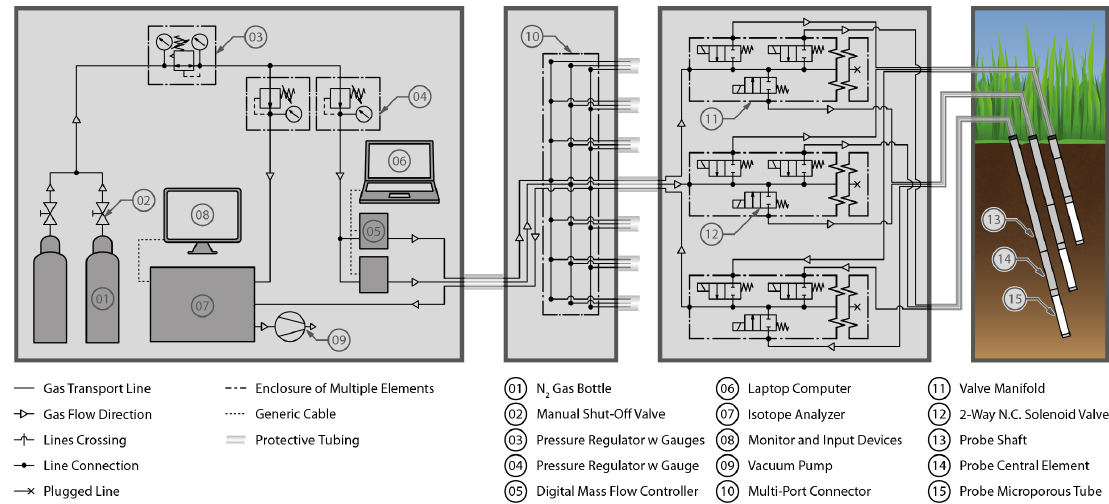
Figure 1. Schematic representation of the in situ pore water stable isotope monitoring system setup according to the DDS